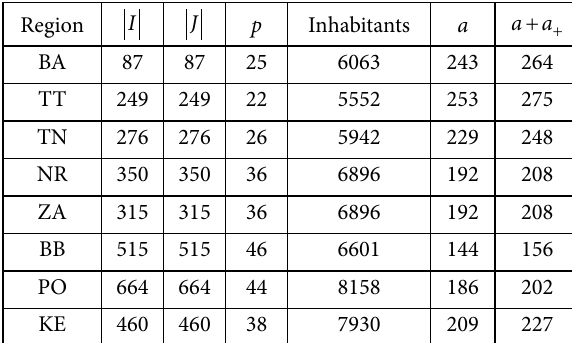
Table 2. The description of used